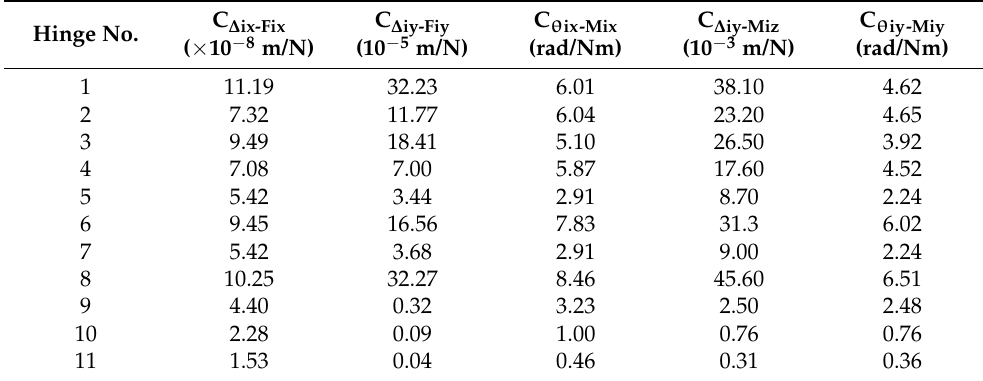
Table 2. The results calculated by the proposed analytical compliance equations.